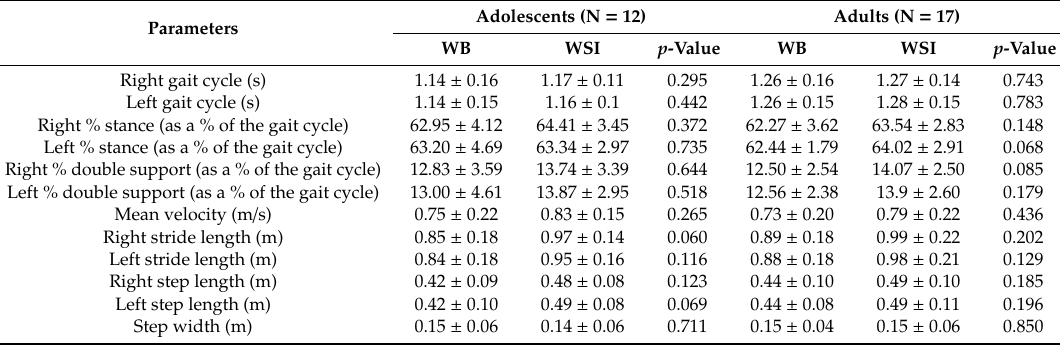
Table 3. Gait variable score (GVS) and gait profile score (GPS) for adolescents and adults under the two walking conditions—walking barefoot (WB); and walking with shoes and FOs insoles (WSI). Adolescents (N = 12) Adults (N = 17) Parameters WB WSI p -Value WB WSI p -Value Right GVS pelvic obliquity ( ◦